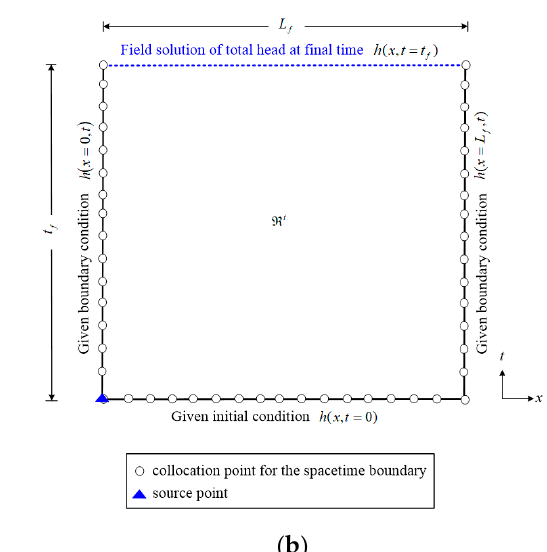
Figure 1. The schematic flowchart diagram of this study.